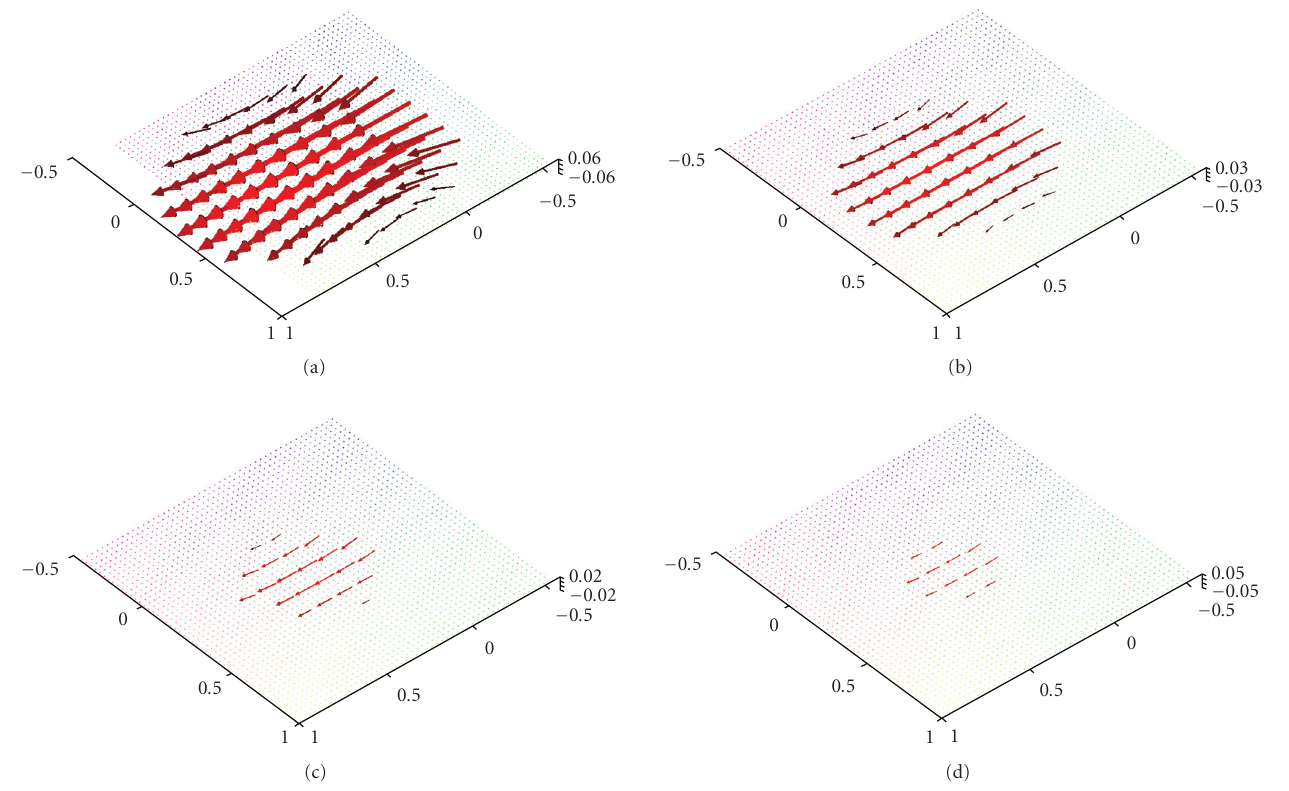
Figure 7: Reconstruction of the vector field f ( x ) = (1 − x 2 2 − x 2 3 ,0,0) (cid:9) with the described algorithm for γ = 0 . 007 using exact, simulated